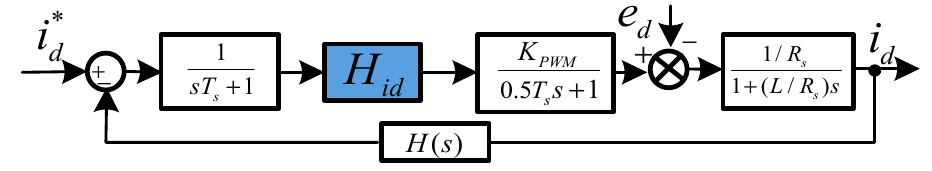
Figure 4. Inner current control loop diagram for the d -axis.